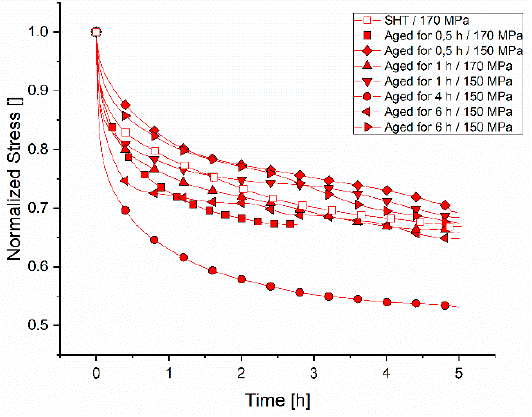
Figure 6. Normalized stress relaxation curves tested at 230 °C.